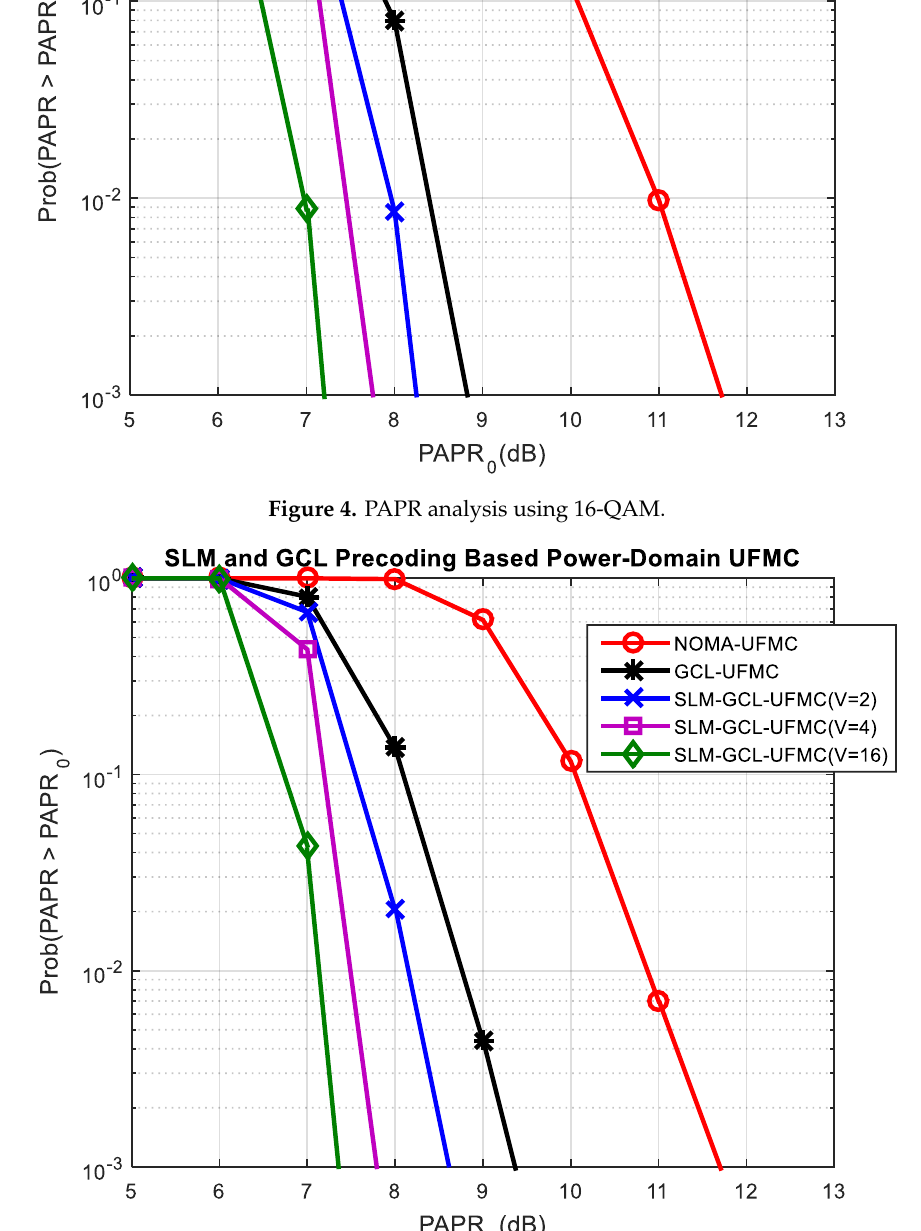
Figure 5. PAPR analysis using 64-QAM.